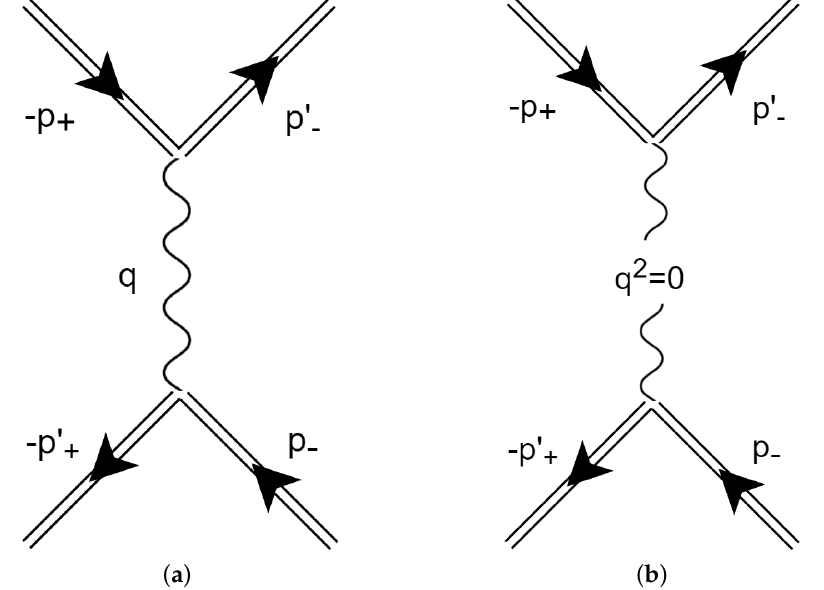
Figure 1. Feynman diagrams of the electron–positron scattering (annihilation channel) in the field of the X-ray pulsar: ( a ) nonresonant and ( b ) resonant cases. Dual lines correspond to the Volkov functions of an electron and a positron (initial and final states). A wavy line represents an intermediate virtual